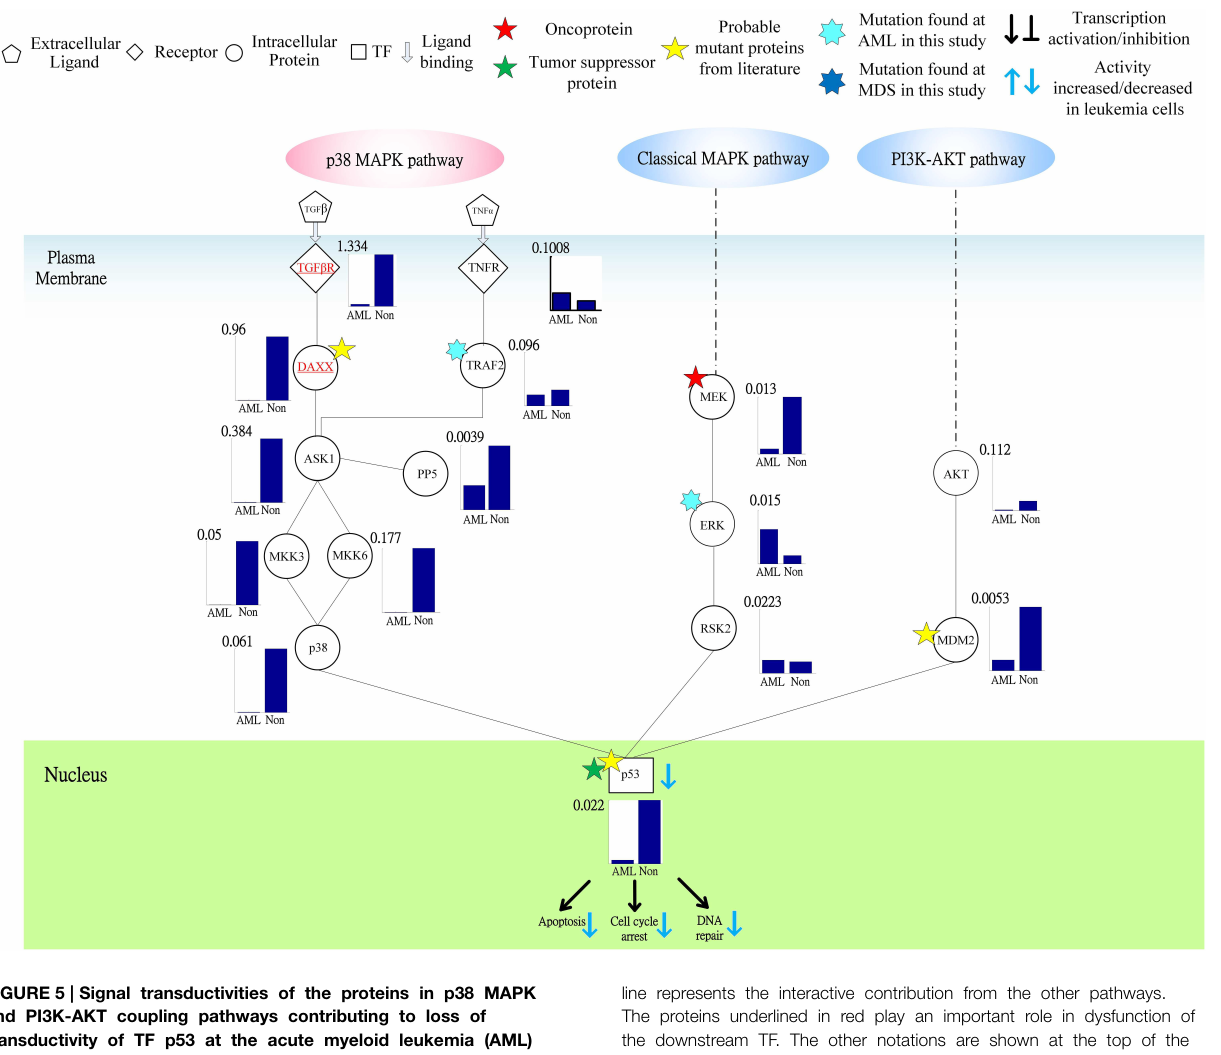
line represents the interactive contribution from the other pathways. The proteins underlined in red play an important role in dysfunction of the downstream TF. The other notations are shown at the top of the Figure. Stars ⋆ denote the locations at which the genetic mutations